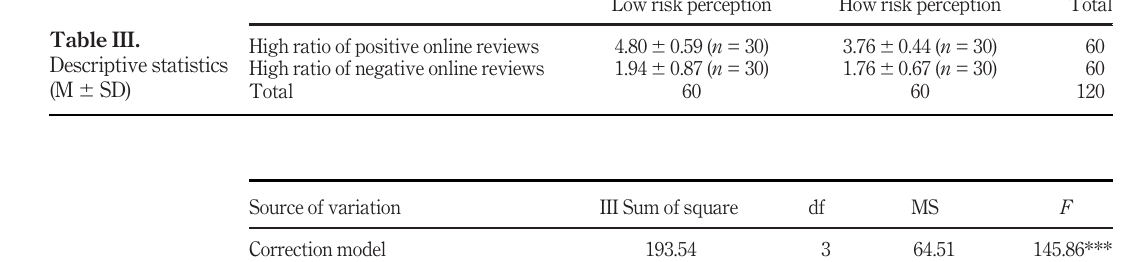
Table IV. Analysis of variance of online reviews, risk perception on